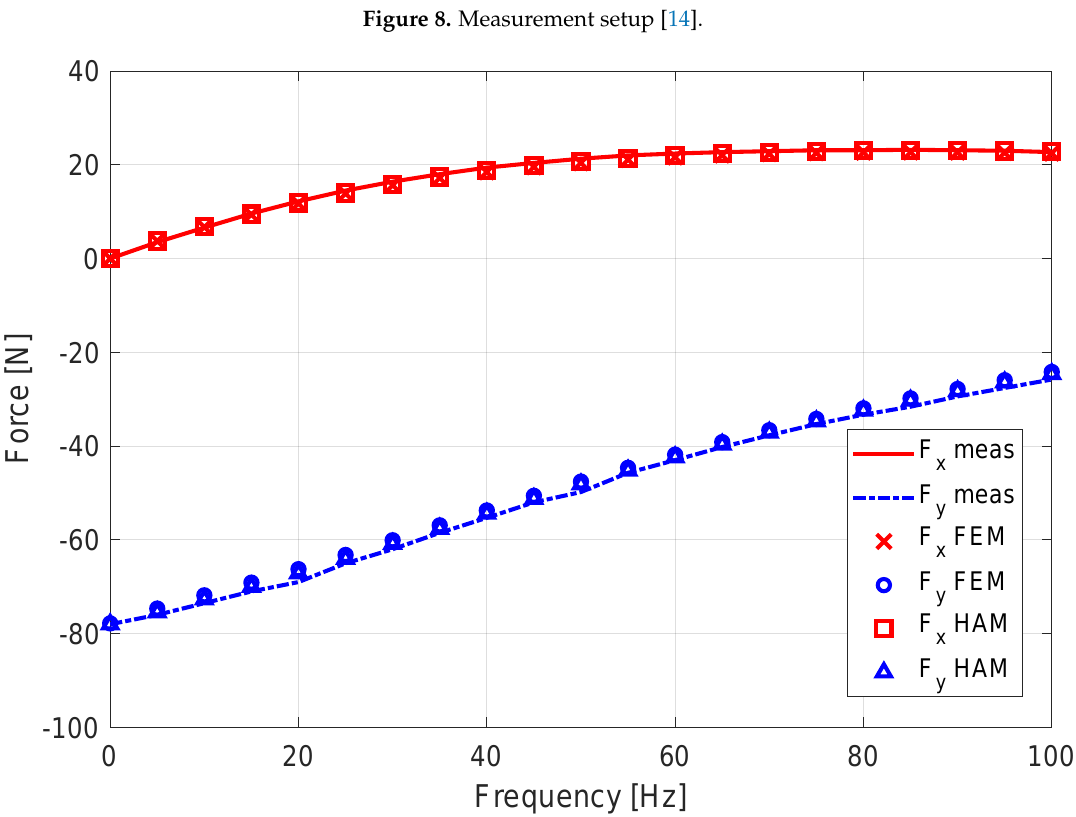
Figure 9. Normal and thrust force for different frequency in comparison with steady-state measurement data ( I p = 10 A, v = 0